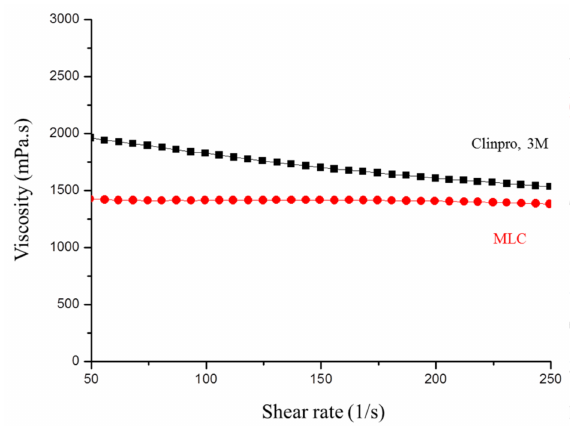
Figure 5. The viscosities of uncured MLC and Clinpro TM with shear rates ranging from 50 to 250 s − 1 .